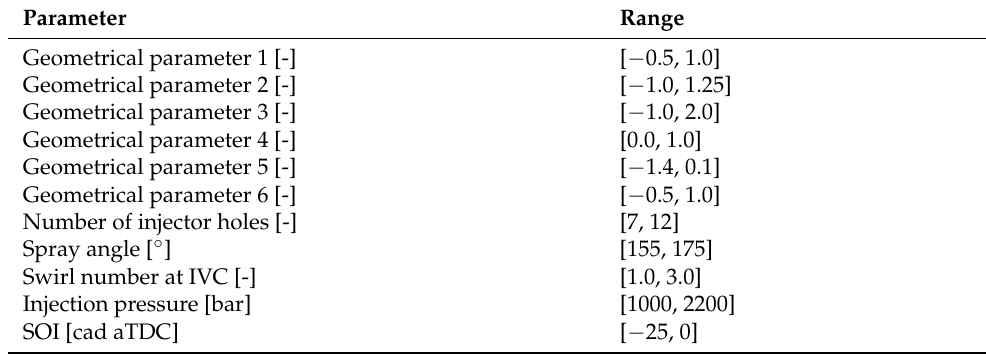
Table 6. Inputs parameters and their ranges considered in the optimization